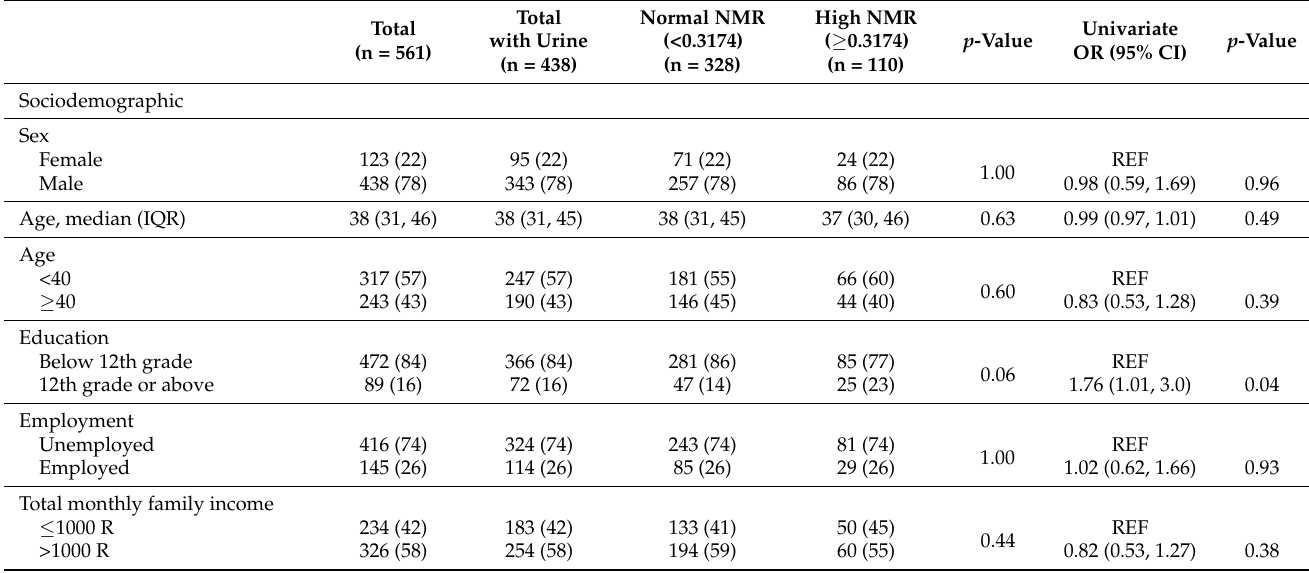
Table 1. Sociodemographic, tobacco use, and clinical characteristics and their univariate association with NMR among adults who smoke and live with HIV in South